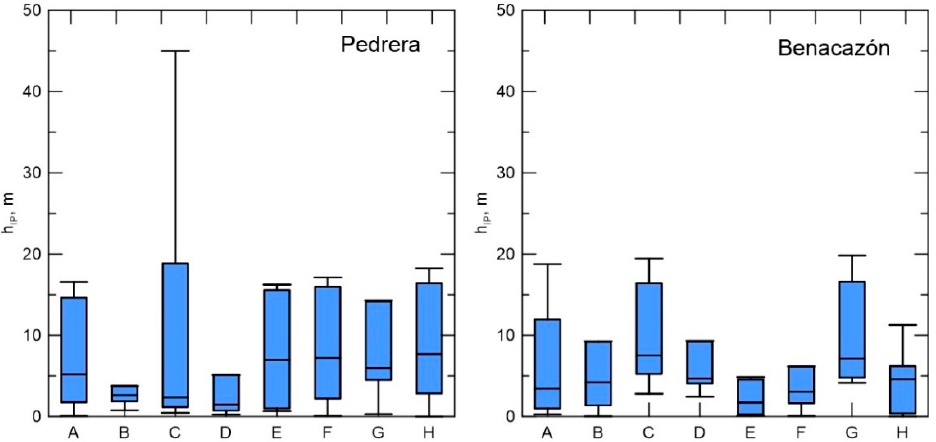
Figure 1. Box and whiskers plot showing the potential at the inflexion point from the WRC (Y axis) for the different management and areas at the two sites: Tillage: A (0–10 cm inter tree row); B (0–10 cm under tree canopies); C (10–20 cm inter tree row); D (10–20 cm under tree canopies) and Cover: E (0–10 cm inter tree row); F (0–10 cm under tree canopies); G (10–20 cm inter tree row); H (10–20 cm under tree canopies). The endings of each box indicate the inter-quartile range times 1.5. The box is defined by the lower and upper quartiles and the line in its center is the median.